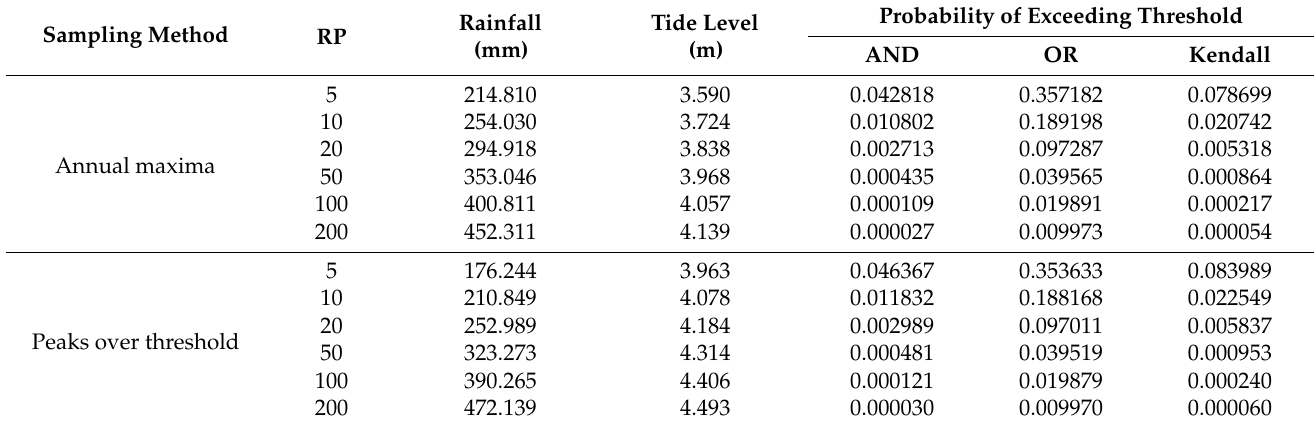
Table 6. Joint exceeding probabilities of different combinations of return